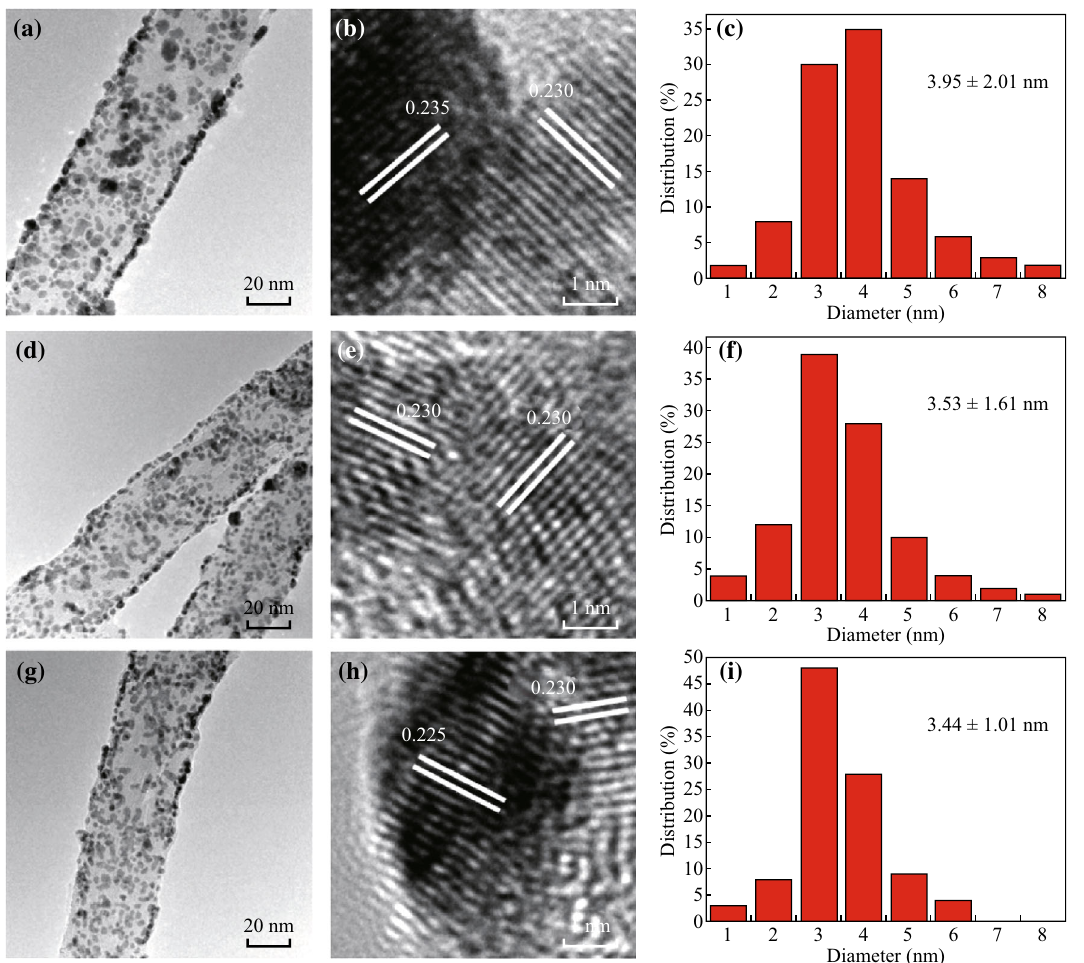
Fig. 1 TEM and HRTEM images of CNTs-PdAu/Pt trimetallic NPs and their size distribution with different Pd/Au/Pt ratios: a , b, c 1:3:2, d , e, f 2:2:2, and g , h, i